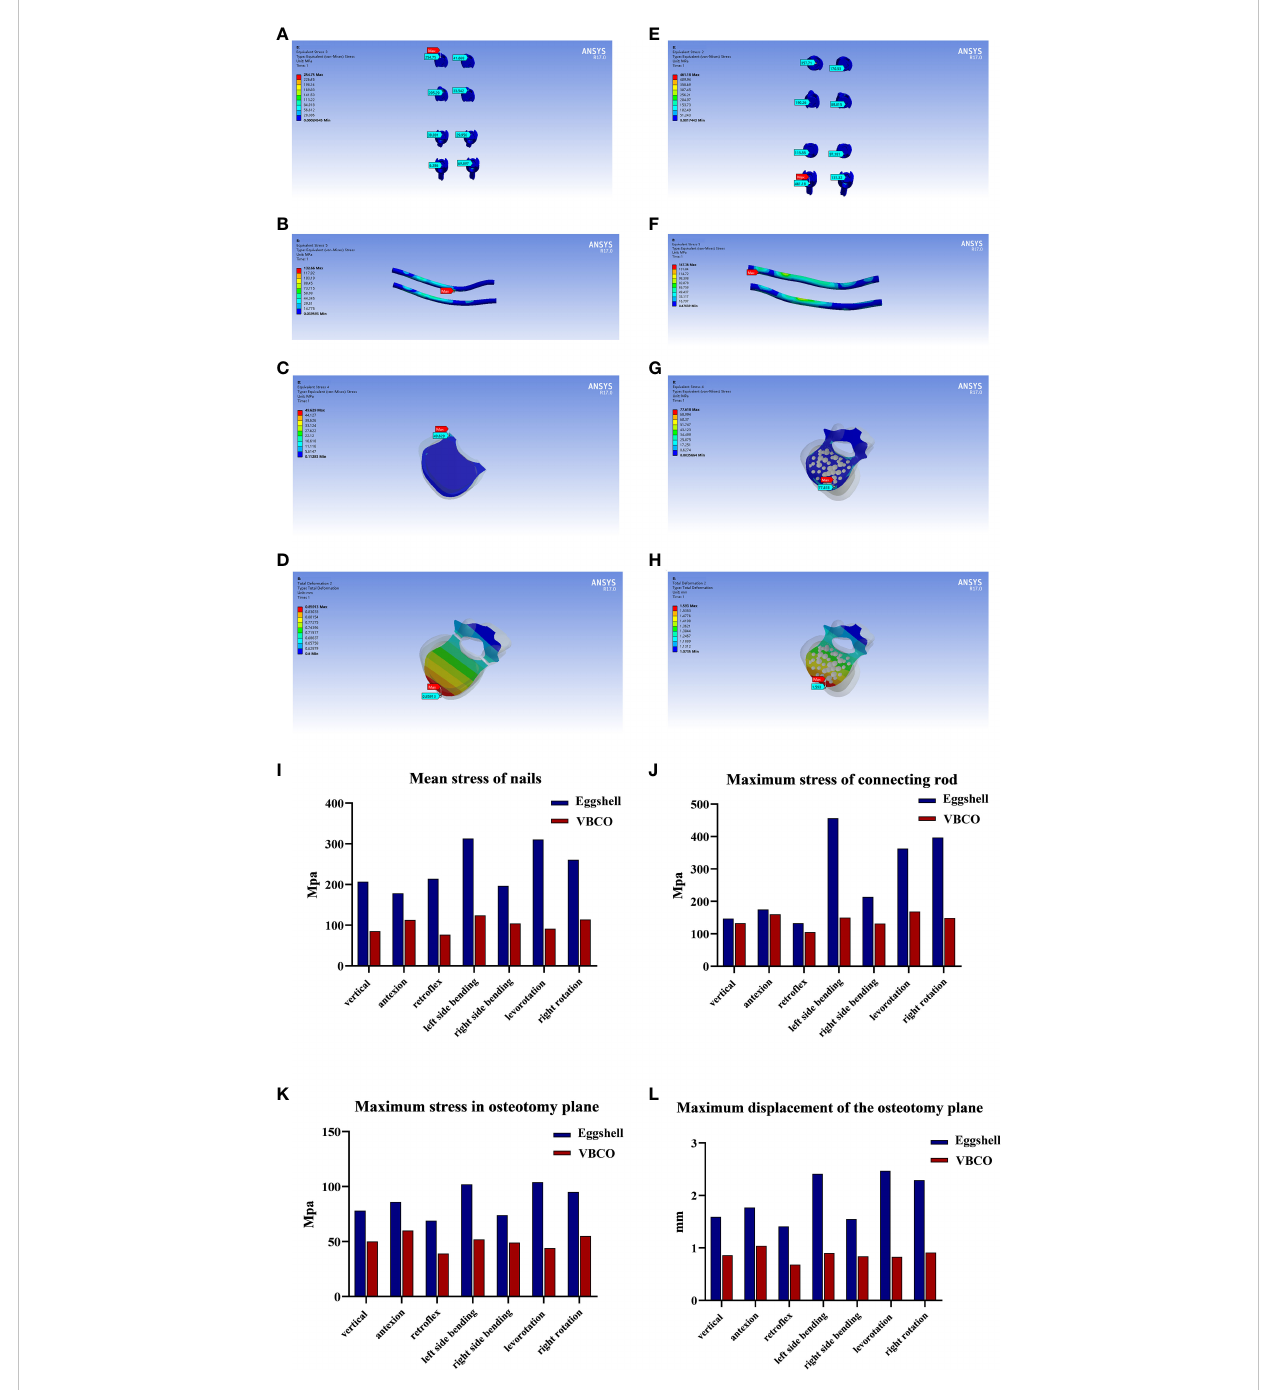
FIGURE 3 FEA of two PSO models with VBCO and eggshell osteotomy. (A – C) Stress distribution of eggshell osteotomy (model 1) nails (A) , connecting rod (B) , and osteotomy plane (C) under different workloads. (D) Displacement distance distribution on the osteotomy plane of eggshell osteotomy (model 1). (E – G) . Stress distribution of VBCO (model 2) nails (E) , connecting rod (F) , and osteotomy plane (G) under different workloads. (H) Displacement distance distribution on the osteotomy plane of VBCO (model2). (I) Comparison of average force on nails of two models under different working conditions. (J, K) Comparison of the maximum force on the rods (J) and osteotomy plane (K) of the two models under different working conditions. (L) Comparison of the maximum displacement of the osteotomy plane of two models under different working